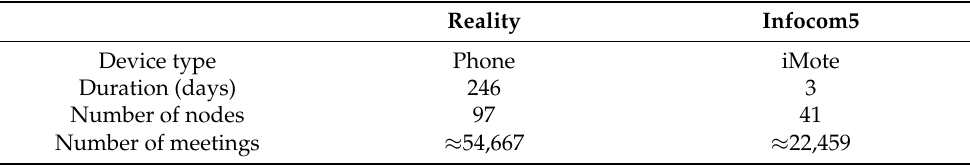
Table 5. Mobility dataset parameters.